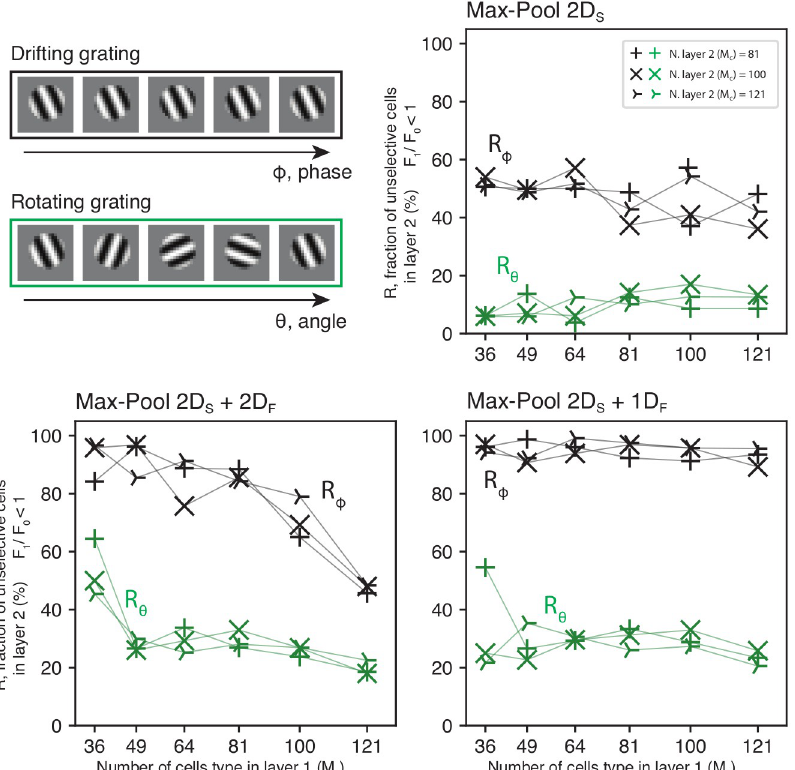
Fig 5. Complex cells population analysis. Here we show how the type of pooling function used and the number of cells type present in the first and second layers of the network ( M population’s properties developed by the model. Top-left . We tested the network’s second layer invariance to phase (drifting) and orientation (rotation) in sinusoidal gratings (see section ‘Drifting grating vs. Rotating grating’). The ratios of cells R ϕ (complex) and R θ (orientation invariant), are defined as the percentage for which F 1 layer of the network. While the network’s second layer shows a strong invariance to a drifting grating (black lines), the same effect is not present for the rotating grating (green lines). This result indicates that the network’s invariant response is specific to the stimulus’s phase and not to its orientation. Overall R acts also in the feature space ( p s = MaxPool 2 D S + 1 D F and p s = MaxPool 2 D S + 2 D F ). Interestingly, for p s = MaxPool 2 D + 2 D , the number of complex-like cells seems to depend on the size of the network’s first layer M S F